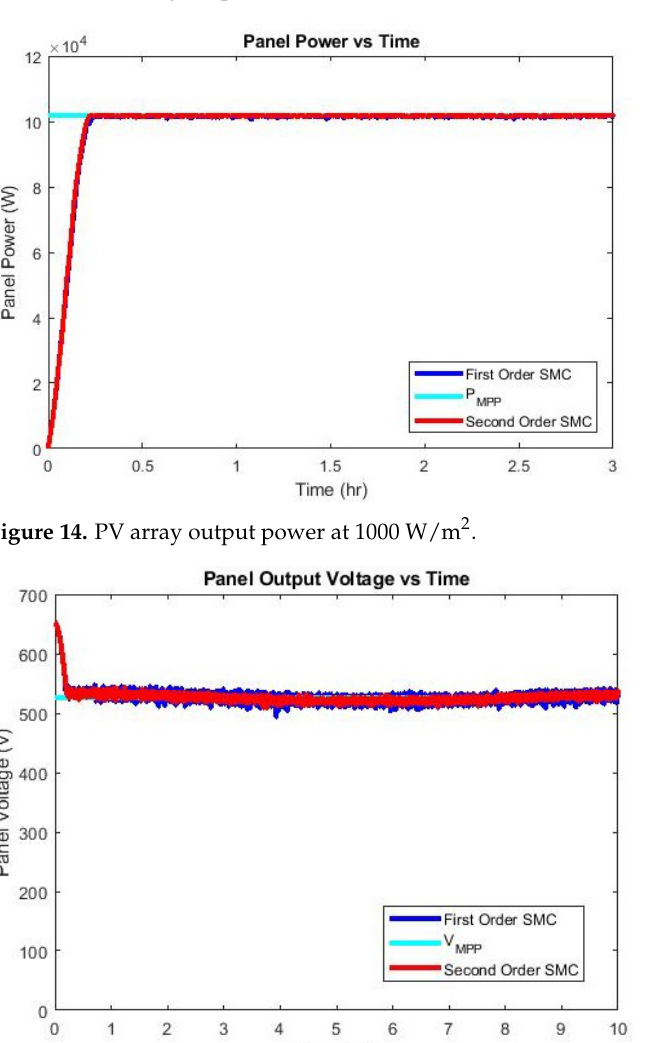
Figure 13. PV array output current at 1000 W/m 2 .